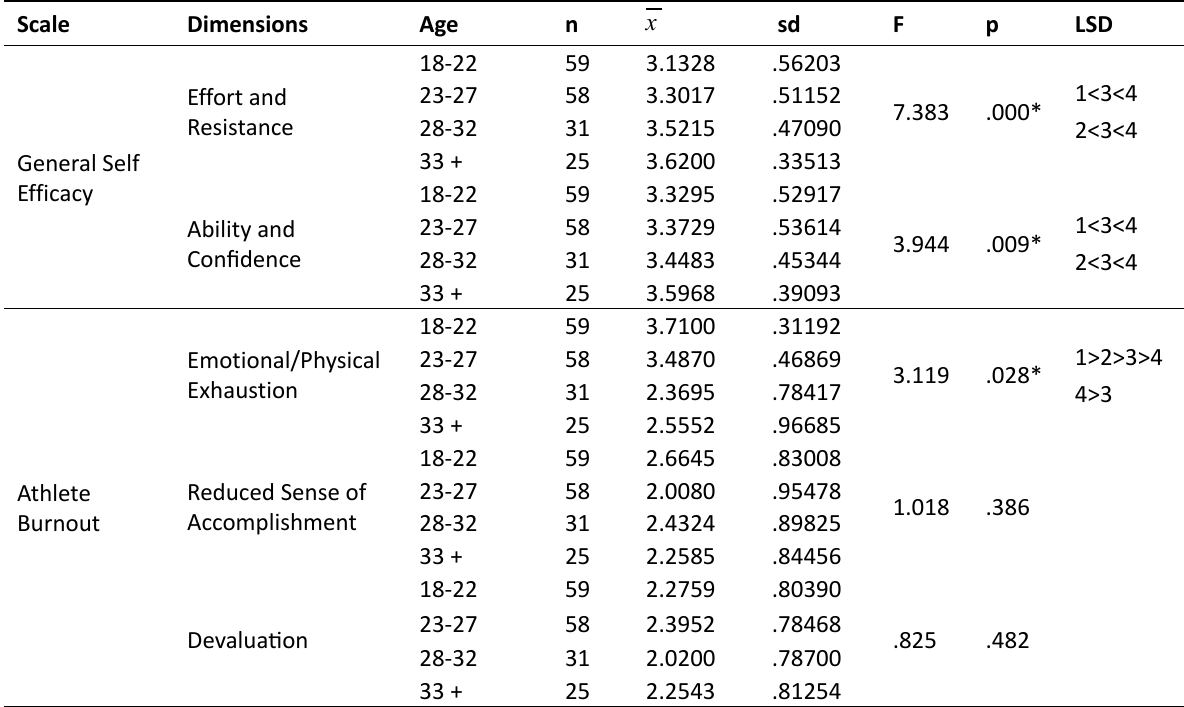
Table 3. Evaluation of general self-efficacy and athlete burnout level by age. Scale